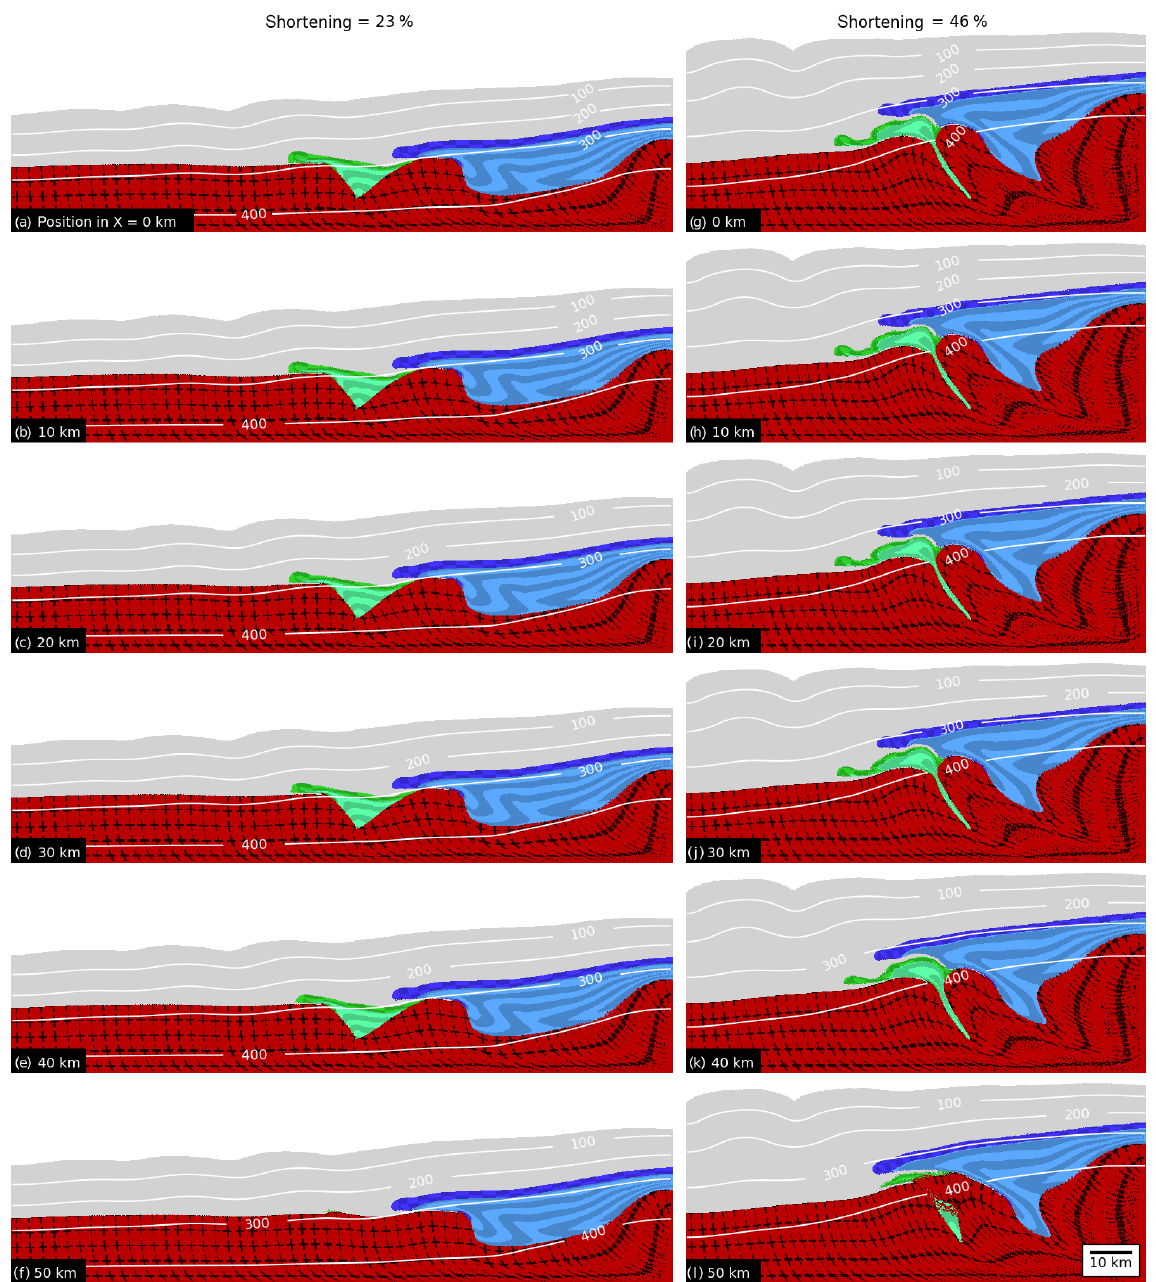
Figure 8. Graph showing lateral cross sections for two different states of bulk shortening for the geometrical evolution of model A.G-3. Cross sections are taken in 10km steps from X = 0 to X = 50km. Additionally, we display the isothermal lines in degrees Celsius ( ◦ C). Columns correspond to the bulk shortening state and rows to cross-section X